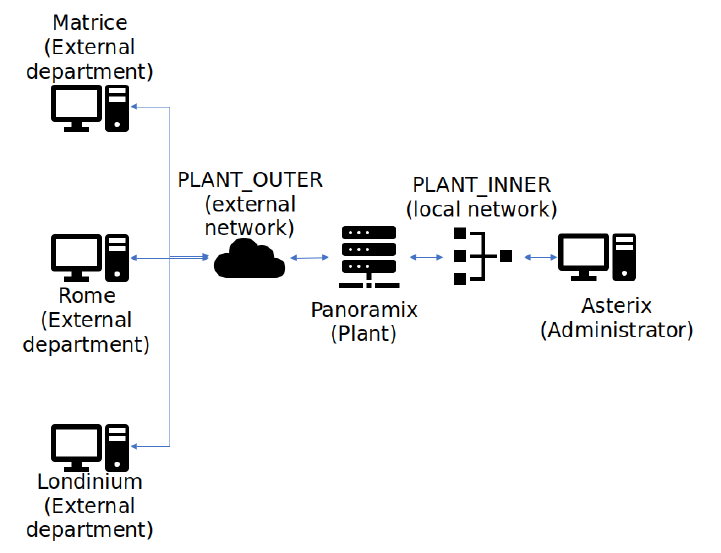
Figure 1. Network